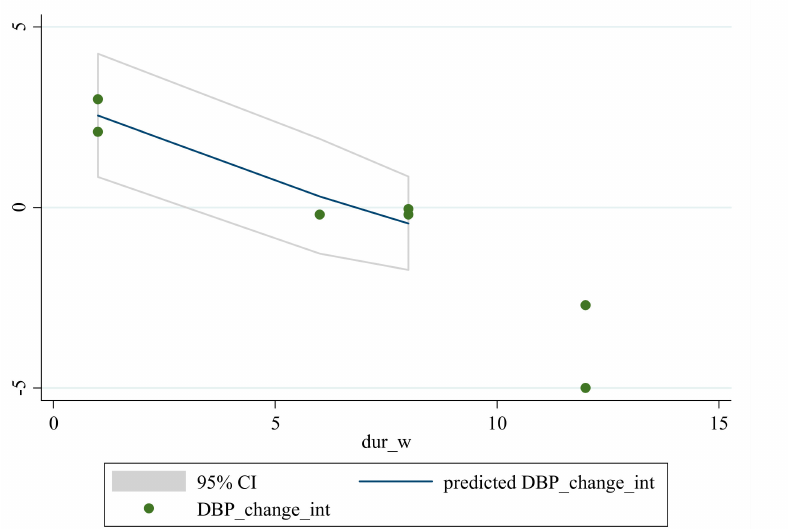
Figure 7. Non-linear dose-response relationships are shown between saffron supplementation and absolute mean differences. Dose-response relationships are shown between the duration of intervention and absolute mean differences in